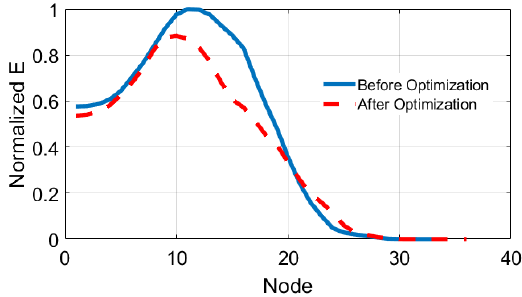
Figure 8. Comparison of electric field intensity of electrostatic ring before and after optimization.